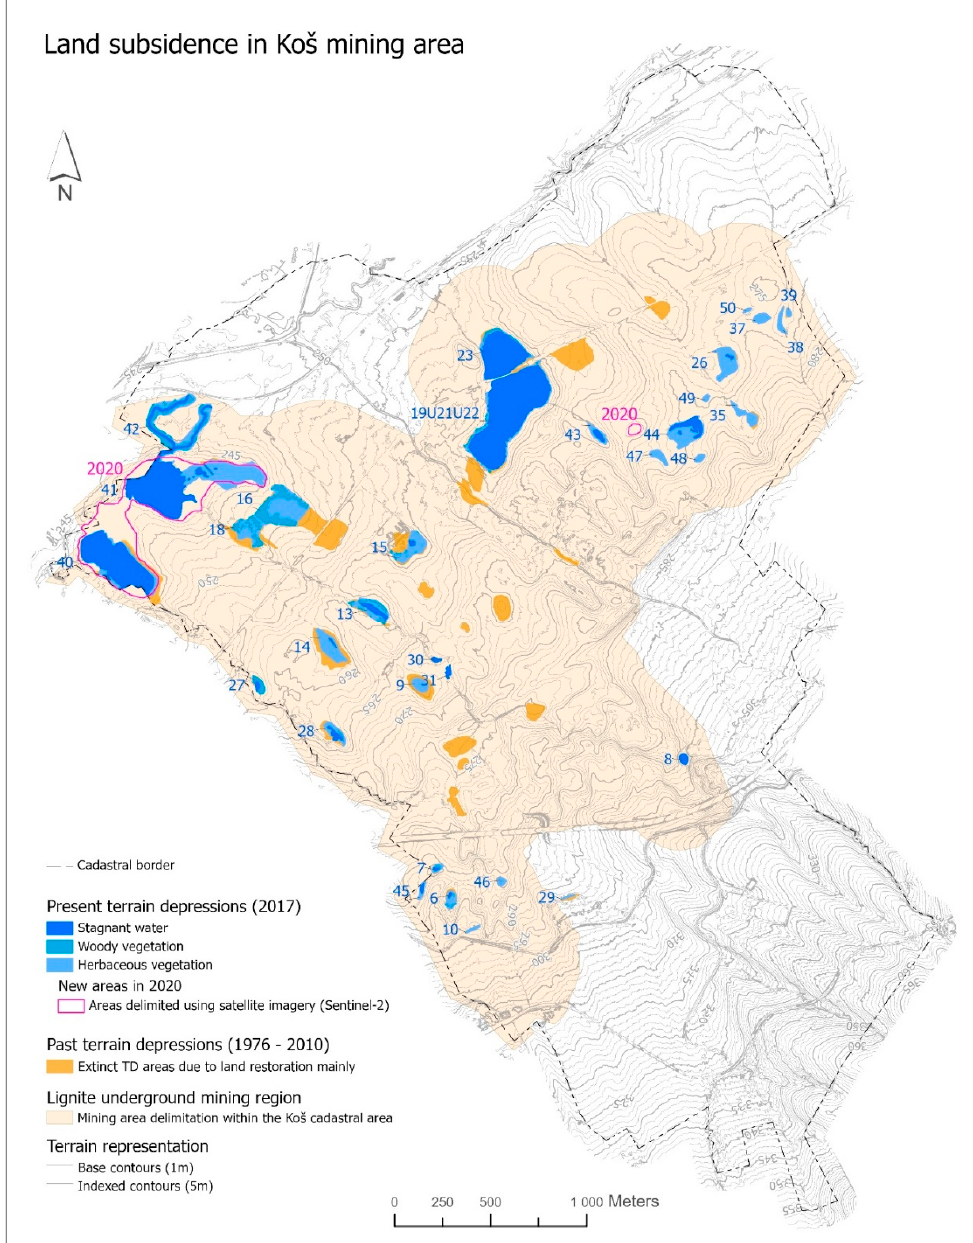
Figure 4. Transformations of wetland in the research area.